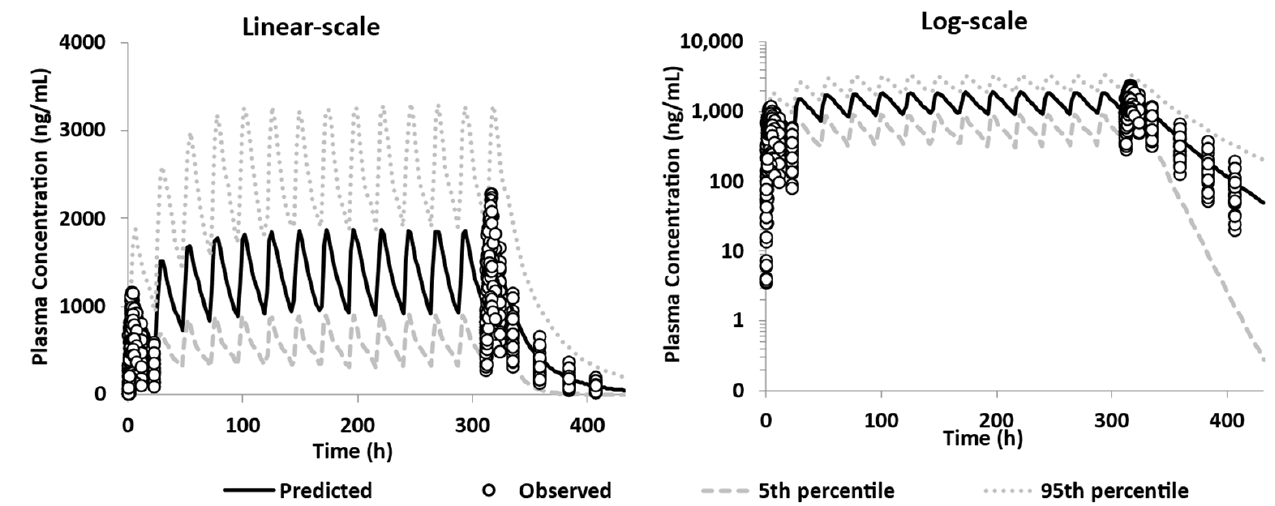
Figure 9. Performance verification of the PBBM model in fed state using the DLM model; overlay observed data from FTIH MAD—200 mg—tablet—single dose daily after a moderate–high fat meal [2].